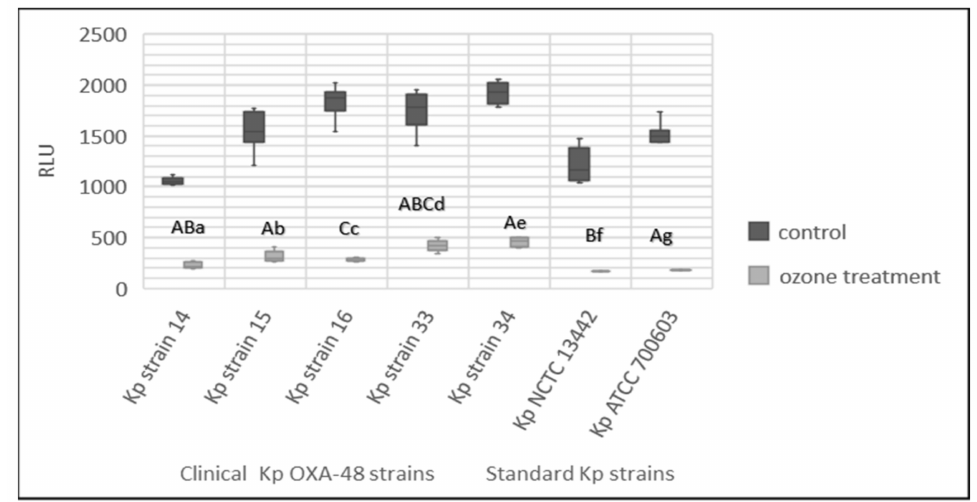
Figure 5. ATP bioluminescence method for control and treated K. pneumoniae strains after treatment of 24 h biofilm with 25 ppm of ozone for 1 h. Lowercase letters, a–g, express the statistically significant difference between the treated and control group for the 7 tested strains (Mann–Whitney U test, p < 0.05). The capital letter A marks the statistically significant difference between Kp NCTC 13442 and strains Kp strain 14, Kp strain 15, Kp strain 33 and Kp strain 34, and the capital letter B marks the significant difference between Kp strain 14, Kp strain 33 and Kp NCTC 13442, while C marks the statistically significant difference between Kp strain 16 and Kp strain 33 (Kruskal–Wallis test, p <